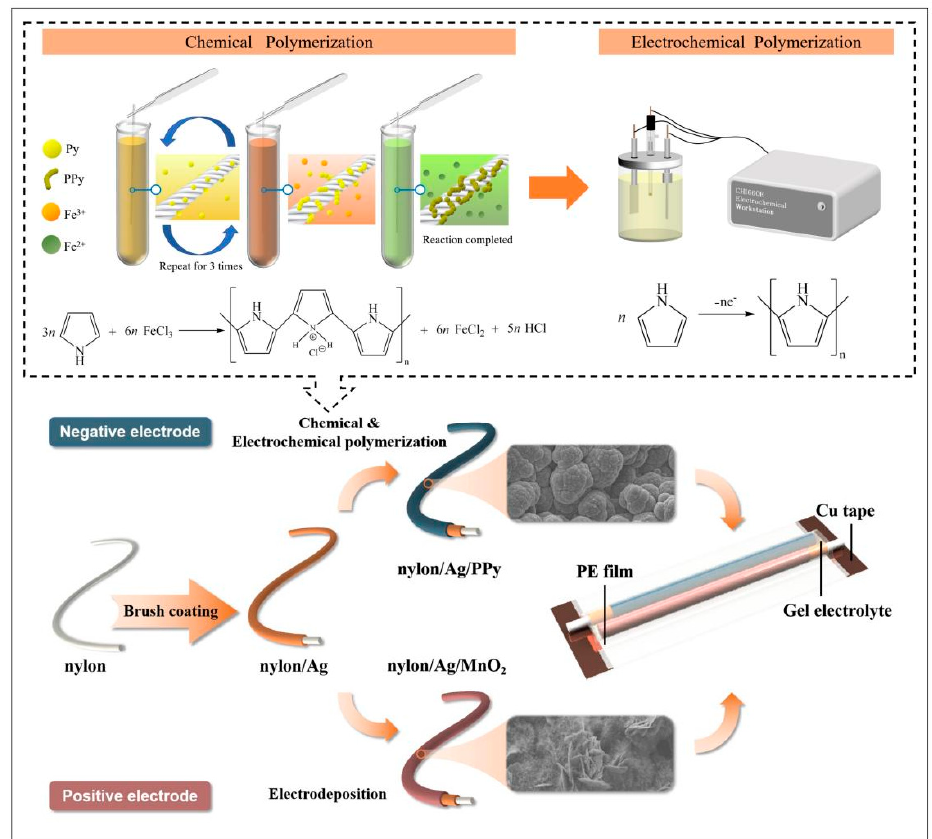
Figure 1. Schematic diagram of the fabrication process of nylon/Ag/MnO 2 and nylon/Ag/PPy electrodes and the assembly of the asymmetric supercapacitor based on these two electrodes (the inset in the upper part shows the mechanism of PPy polymerization and the fabrication of the nylon/Ag/PPy electrode).